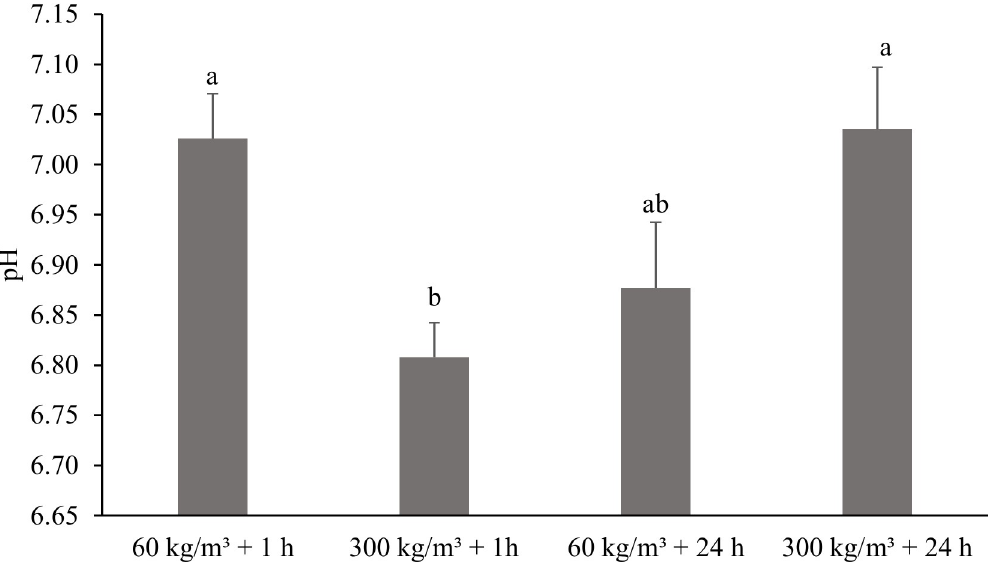
Fig 2. pH values of Nile tilapia fillets at different densities (60 and 300 kg m -3 ) and depuration times (1 and 24 hours). Lower case letters indicate significant difference (P = 0.0027) by Tukey’s test. Vertical bars indicate standard error of the